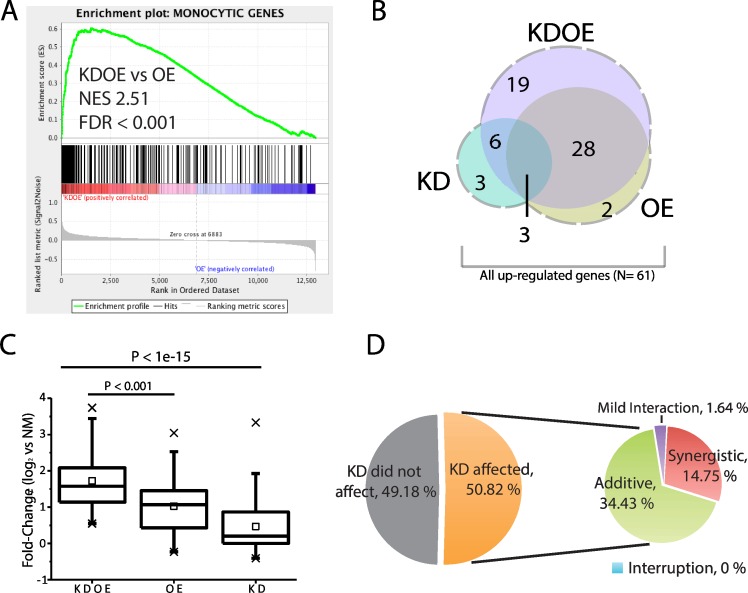
Active interaction of two TRNs in monocytic gene regulation.(A) Analysis of KDOE against OE-only shows significant enrichment. (B) Venn diagram of genes upregulated in each treatment. (C) Box-plots of fold-change distribution for all genes upregulated (N = 61, x: 1% and 99%, ☐: mean). (D) Pie charts showing the interactions between two TRNs in regulating monocytic gene expression.